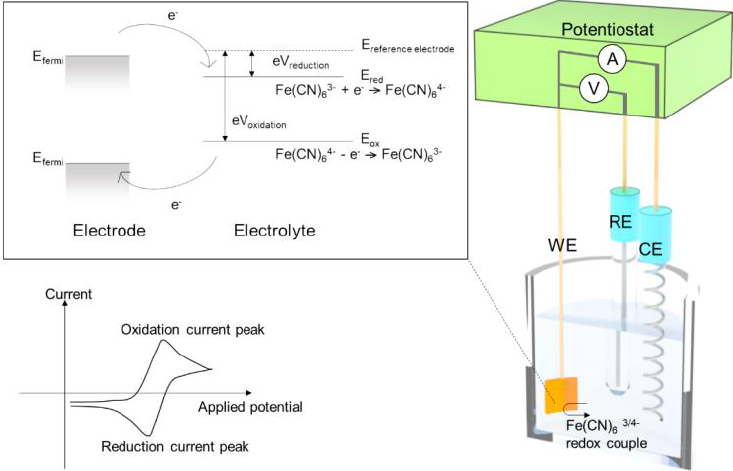
Figure 3. A schematic diagram for electrochemical redox reaction of Fe(CN) 63 − /4 − in a three- Figure 3. A s chematic diagram for electrochemical redox reaction of Fe(CN) 6 3−/4− in a three-electrode electrode system.